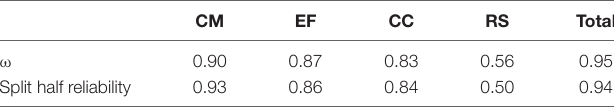
TABLE 5 | Reliability coefficient of parenting stress of two-child mothers ( n = 263).